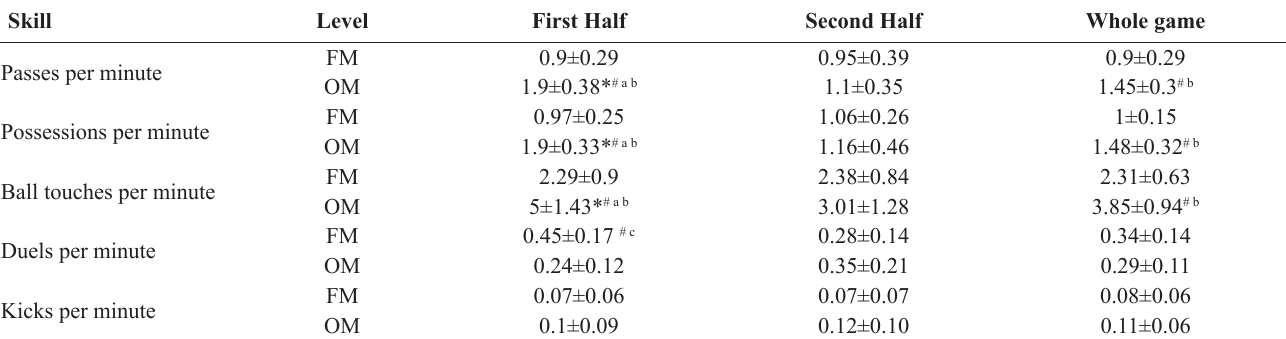
Table 4. Frequency of the execution of scout variables of technical skills during the official match (OM) and pre-season friendly match (FM), normalized by time on the court. Results are presented in mean ± standard